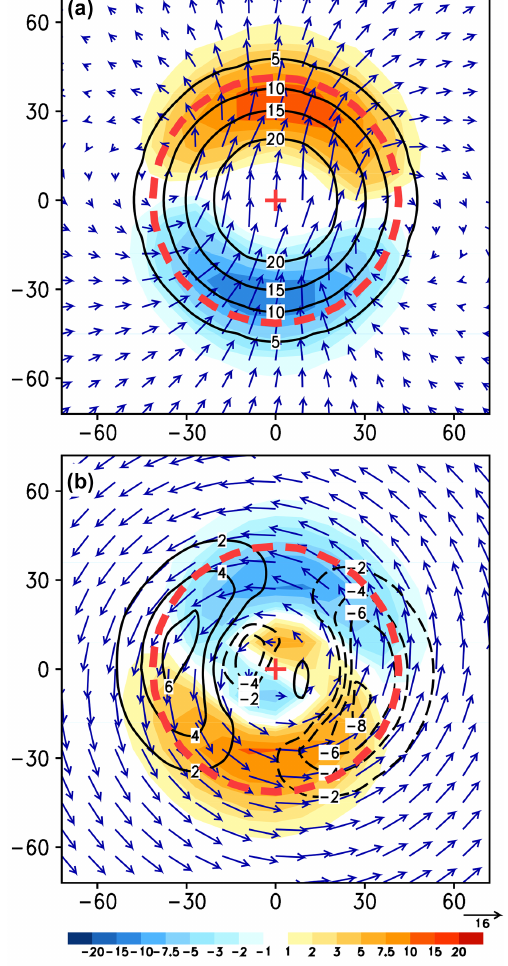
Figure 9. (a) HA1 (shaded, 10 − 10 m 2 s − 2 Kkg − 1 ) and (b) HA2 (shaded, 10 − 10 m 2 s − 2 Kkg − 1 ) with the wave-number-one and symmetric components of potential vorticity (contours, 10 − 6 m 2 s − 1 Kkg − 1 ) and winds (vectors, ms − 1 ) at 700hPa after 18h of integration. The dashed circle indicates the radius of maximum wind.